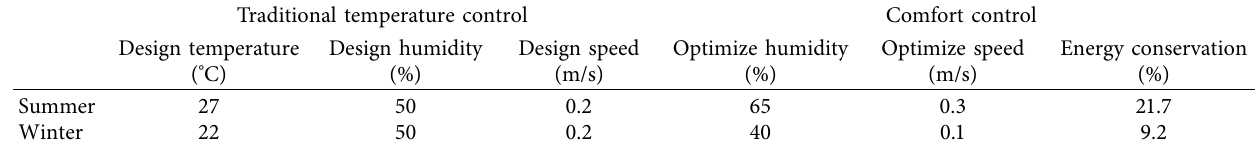
Table 4: Comparison of environmental variables and energy saving before and after